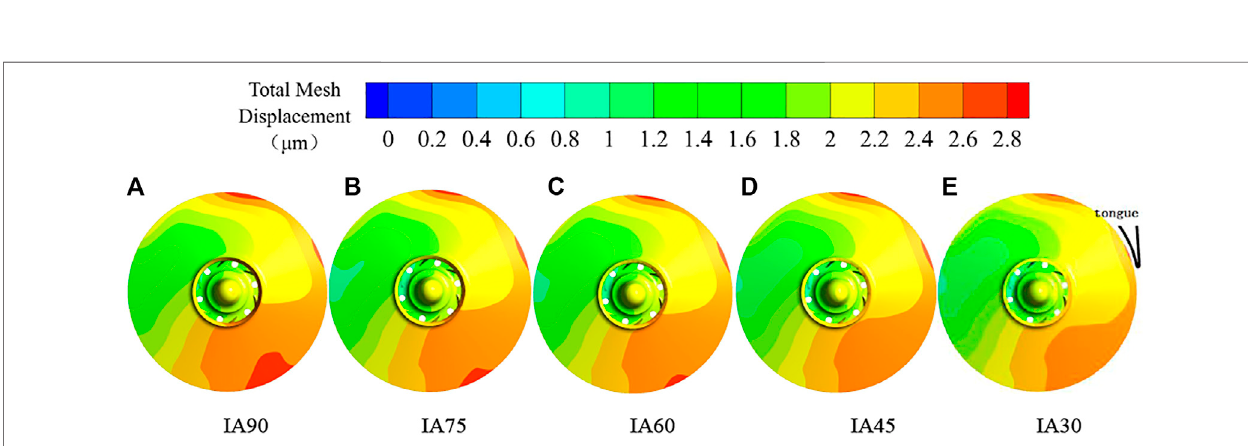
FIGURE 14 | Cloud map of vibration displacement of impeller under the design fl